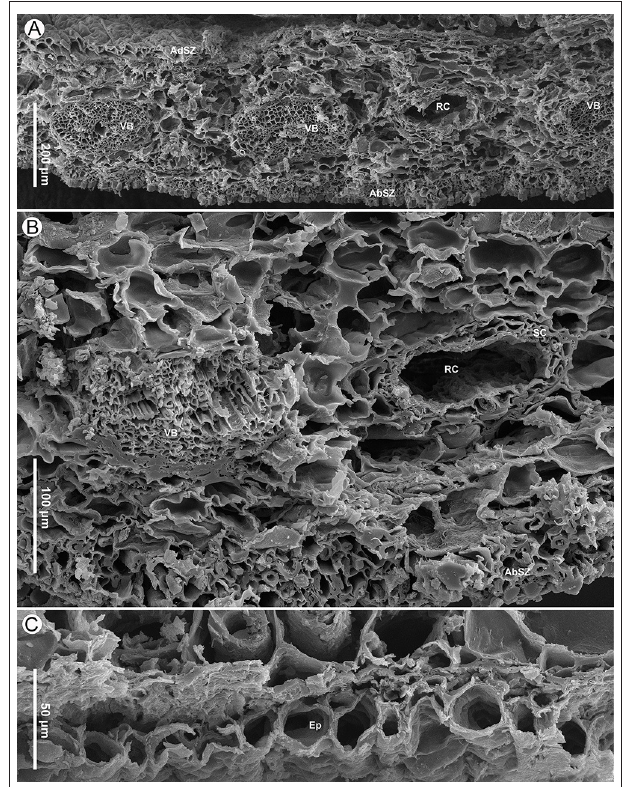
FIGURE 6 | Seed scale anatomy of Pinus prehwangshanensis sp. nov., specimen MMRH171, SEM. (A) Transverse section of a seed scale in the middle part showing a sclerified cortex (AbSZ – abaxial sclerified zone; AdSZ – adaxial sclerified zone) and vascular bundles (VB) alternated with resin canals (RC). (B) Transverse section of a seed scale showing a vascular bundle (VB) and a resin canal (RC) with two concentric rows of sclerified cells (SC); note a sclerified zone (AbSZ) in the abaxial cortex. (C) A seed scale cross-section showing abaxial epidermal cells (Ep).